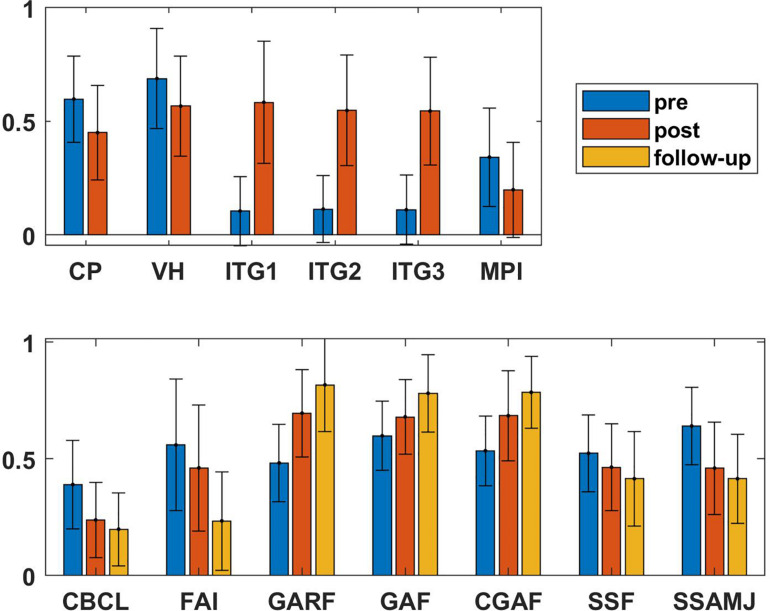
Visualization of the pre, post, and follow-up values of the scores of the multi-problem families. To allow comparability, all values were rescaled by the range of the respective questionnaire, i.e., 1 corresponds to the maximum and 0 to the minimum values. By this, the pre/post/follow-up differences are comparable. Symptom scores like MPI, CBCL and SSAMJ significantly decreased during treatment and continued to decline in the 3-year follow-up period. Accordingly, the scales assessing the functioning of the families increased (GAF, CGAF, and GARF). The measures for general risks of the families (FAI and SSF) decreased, too. The largest change was achieved in the ITG of the families. The scores for treatment expectation and collaboration are reversed, i.e., high score represent low expectations and missing collaboration. CBCL: Children Behavior Check List, CGAF: global functioning of the child, CP: collaboration, ITG: ITG, FAI: family adversity index, GAF: global functioning of the caregiver, GARF: global relational functioning of the family, MPI: Mannheim Parental Interview, SSF: (impaired) Social Self-Sustainability of the family, SSAMJ: (impaired) Social and Working Skills of the Minor, VH: treatment expectation.